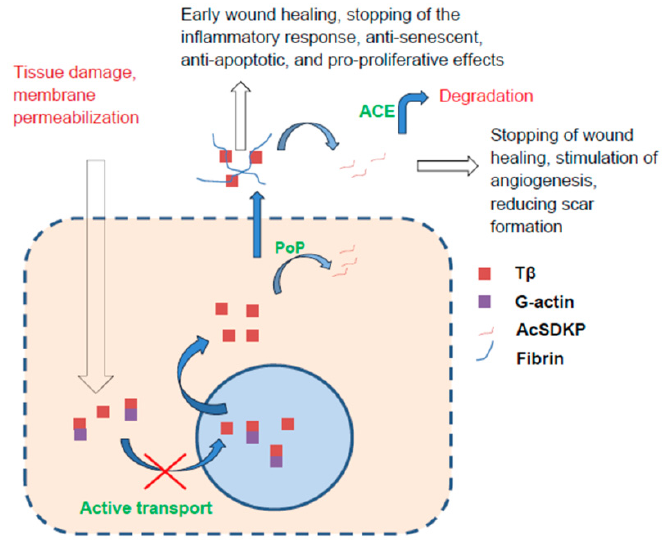
Figure 7. Schematic representation of intracellular and extracellular effects of thymosin- β 4 (T β 4) and its fragment AcSDKP. Adapted from our earlier publication [144].